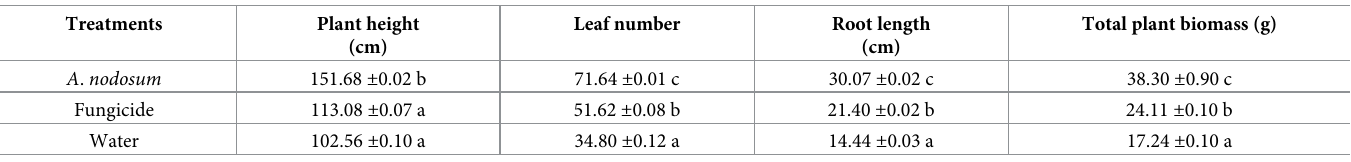
Table 2. Effect of A . nodosum extract application on plant growth parameters in tomato.